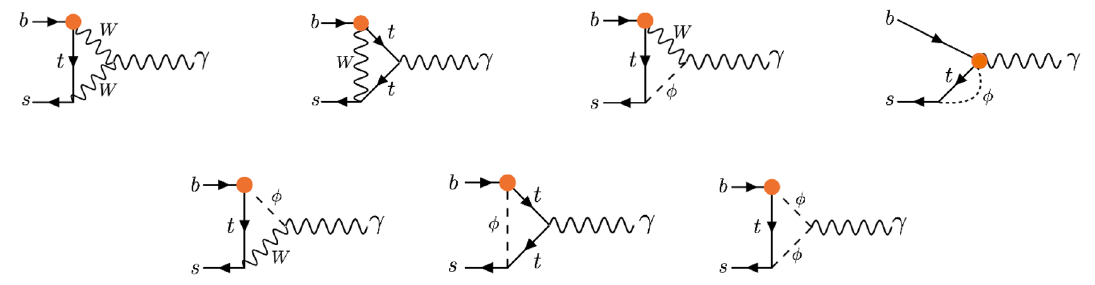
Figure 7. Diagrams generating contributions to b → sγ from the Q Hud operator.